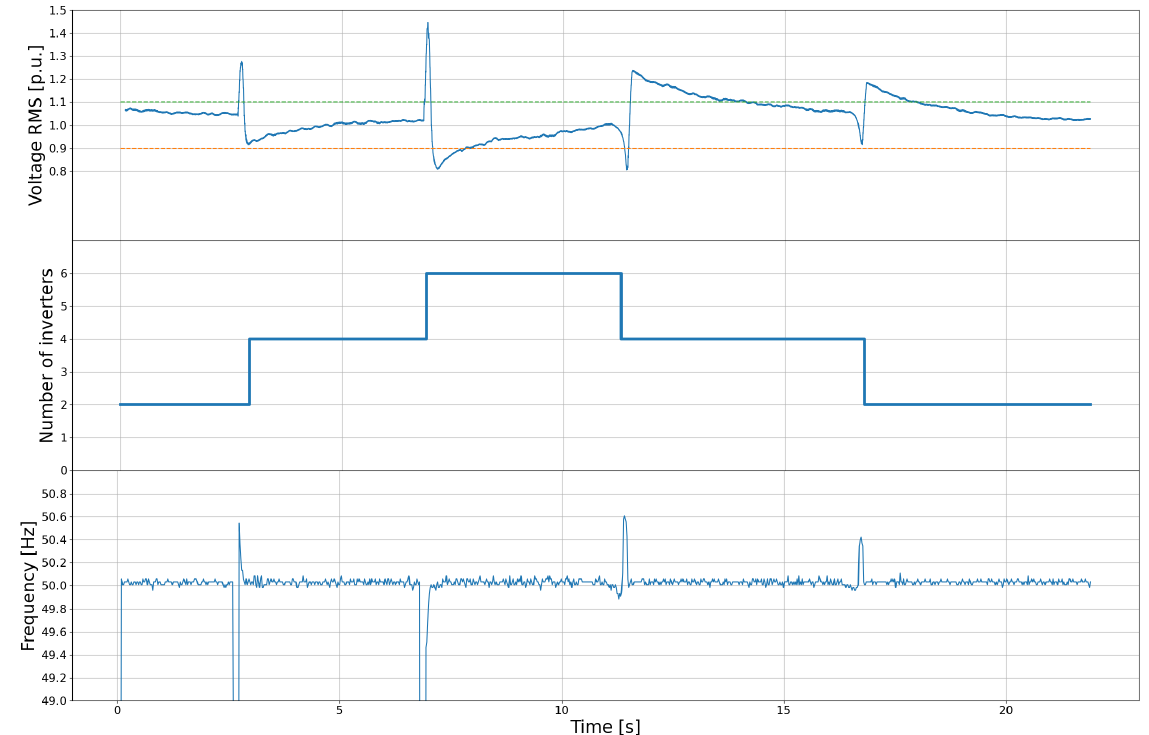
Figure 10. The sequence of connection and removal, two inverters at the same time. The connection and removal of 4 inverters into 2 inverters MG has violated levels defined in standards (see Figure 11). In that sub-case, the emulator fails most of the repetition. If the connection of MGs with that much indifferent power level is needed, then voltage spikes protection devices alike varistor, surge protectors, or special protection circuits are necessary to